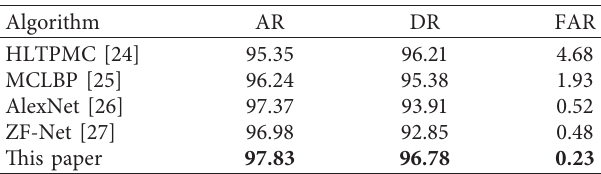
Figure 4: The experimental data examples. (a) Smoke images. (b) Nonsmoke images. Table 3: The experimental results are compared with other methods.